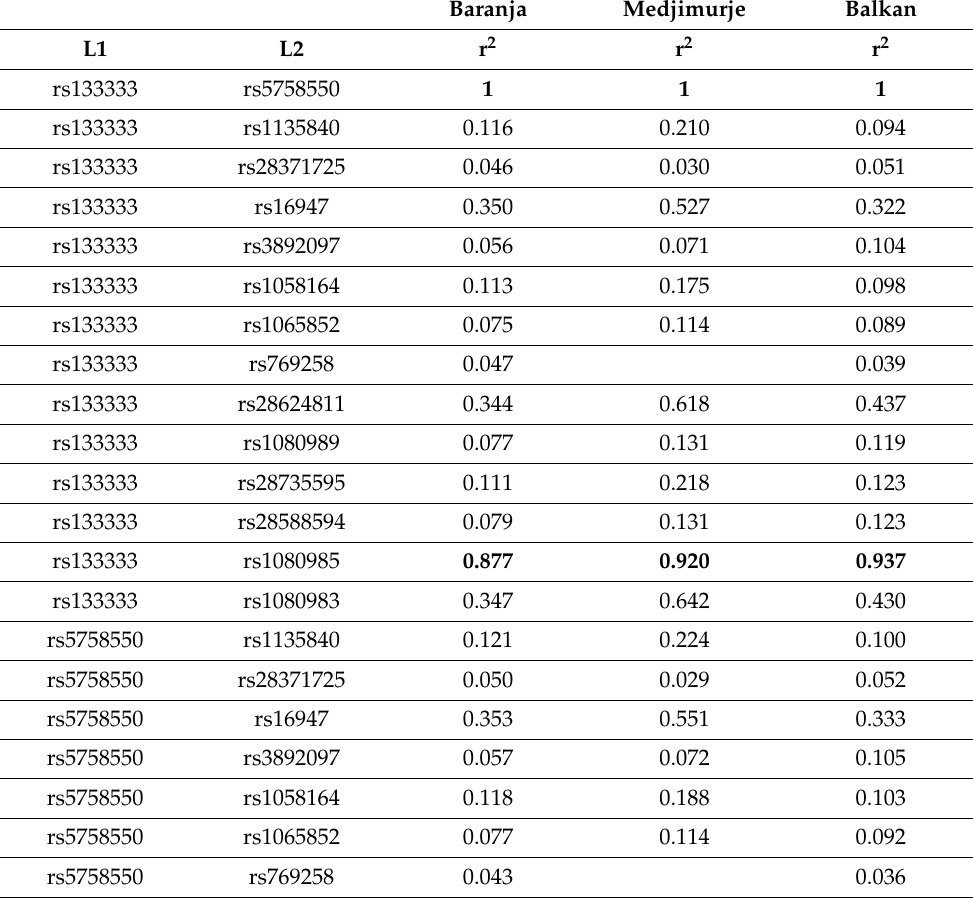
Table 2. LD values (r 2 ) between pairs of polymorphic sites in the CYP2D6 gene regulatory and gene-coding regions in the three Croatian Roma groups (Baranja, Medjimurje and